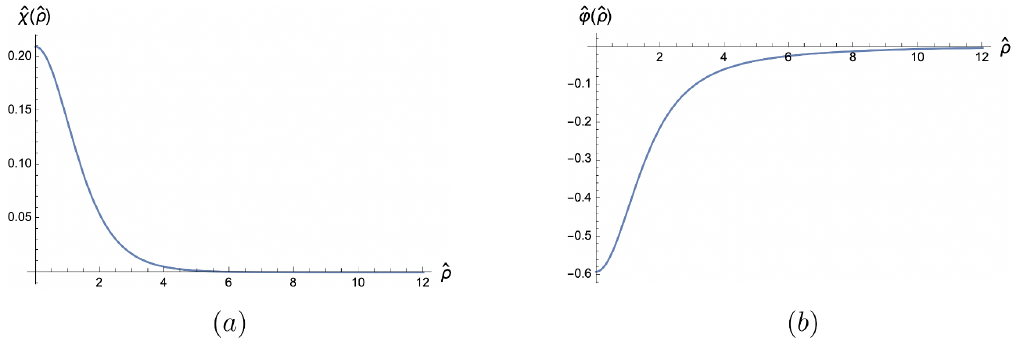
Figure 4 . Solution for d = 4 . (a) Plot of the rescaled profile ˆ χ (ˆ ρ ) . (b) Plot of the rescaled gravitational potential. The true values of χ and ϕ are related to the rescaled ones through (2.28) and (2.30).